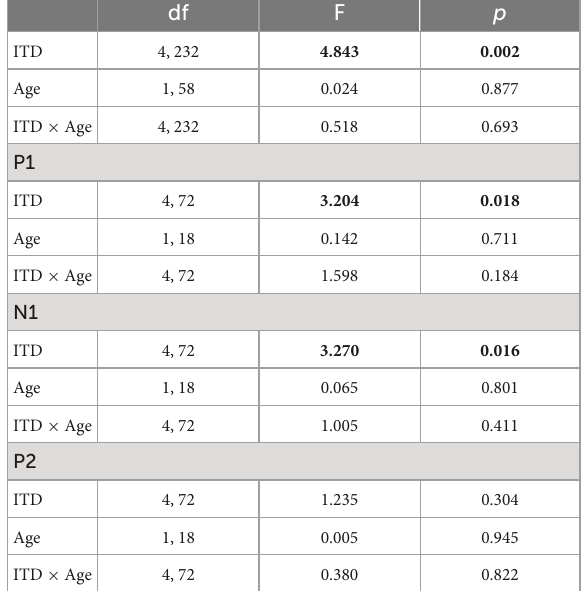
TABLE 4 Repeated-measures analysis of variance (ANOVA) results for source-localized laterality index (LI)